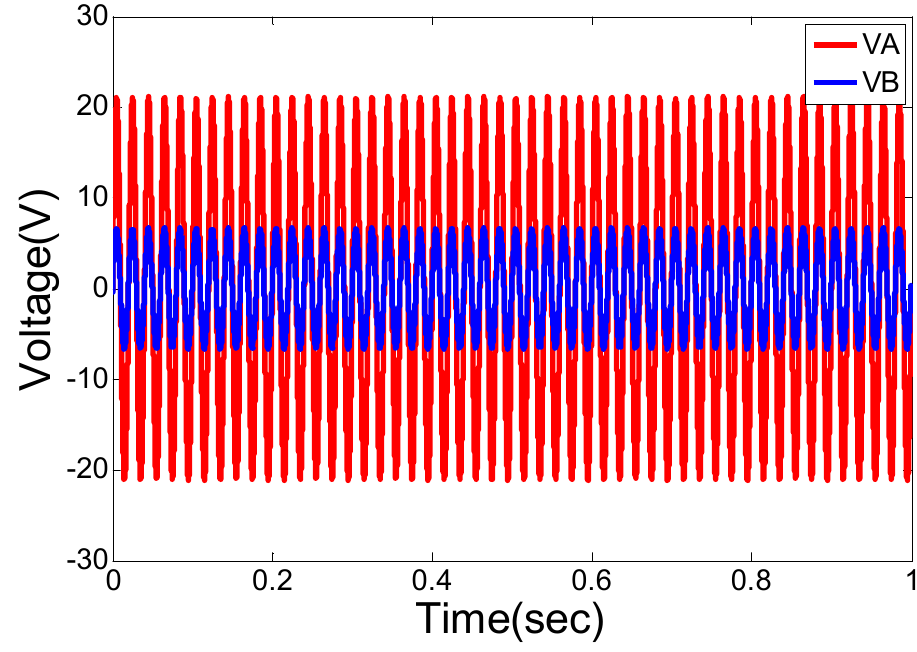
Figure 3. V A and V B voltage waveform graph.